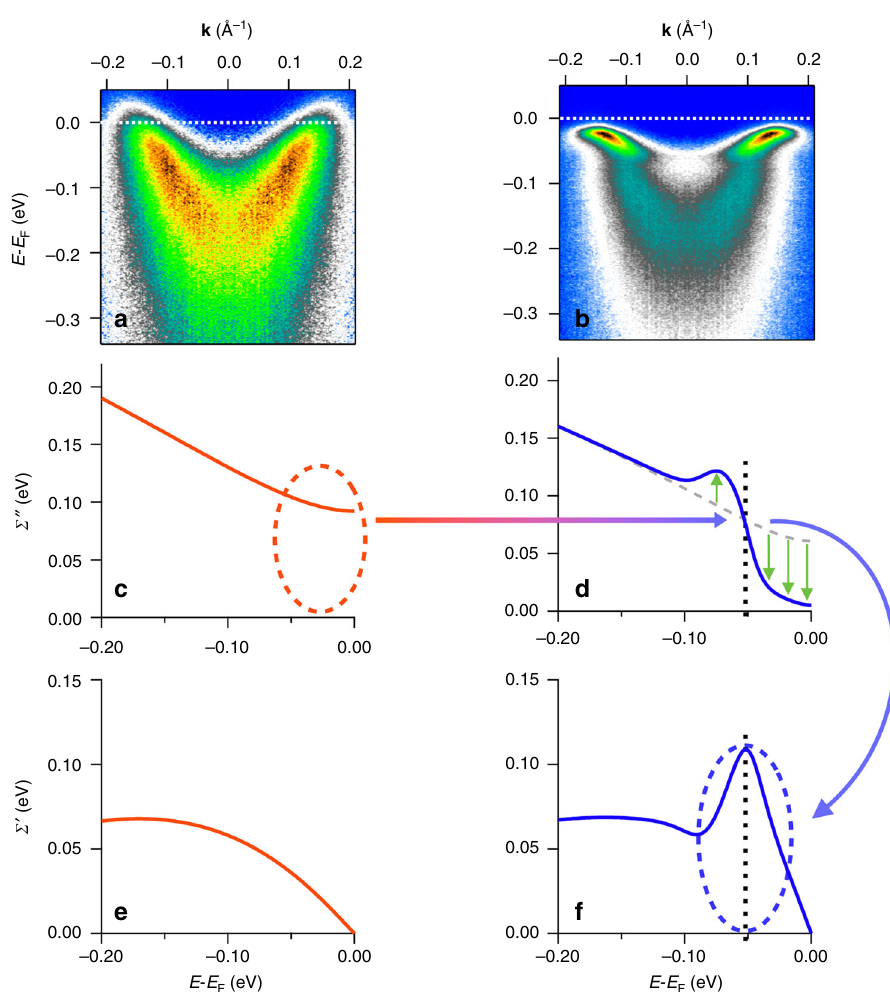
Fig. 4 Conversion of electronic correlations. This fi gure summarizes the temperature evolution of the electron spectral weight A ( k , ω ) a , b and the electronic self-energy Σ ( k , ω ) c – f . c highlights the large low-energy Σ ″ (incoherent scattering) that is present in the normal state, as indicated by the dashed oval. d shows that as the temperature is lowered into the superconducting state this low-energy incoherent scattering is undressed or gapped, i.e., the low-energy portion of Σ ″ tends toward zero below the energy of the dashed line, along with a slight increase in Σ ″ at higher energy (partial weight transfer). Among other things this creates the well-de fi ned quasiparticle states in A ( k , ω ) at low energy of b . Causality requires that associated with this change in Σ ″ is a change in Σ ′ , as observed in f and highlighted by the blue dashed oval. This shows up as the strong kink effect/mass renormalization in b . Hence, the large diffusive scattering above T C is converted to a strong kink effect and mass renormalization — an effect that is much larger for the antinode than the node because the normal state diffusive scattering is much larger for the antinode than the for the